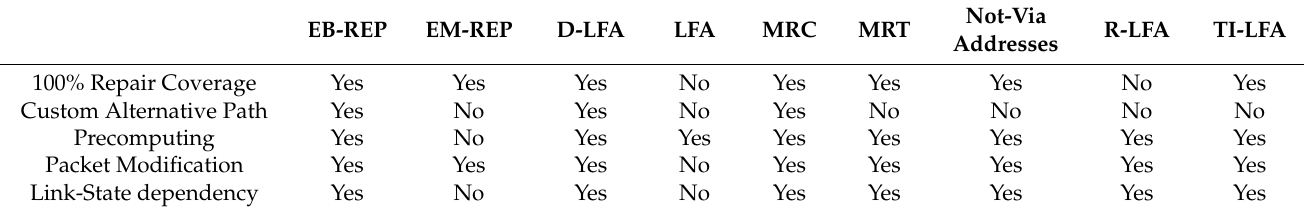
Table 13. Comparison of EB-REP with other FRR